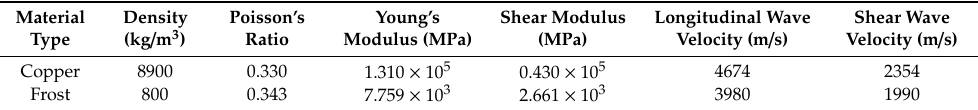
Table 1. Material parameters and wave velocity calculation results.